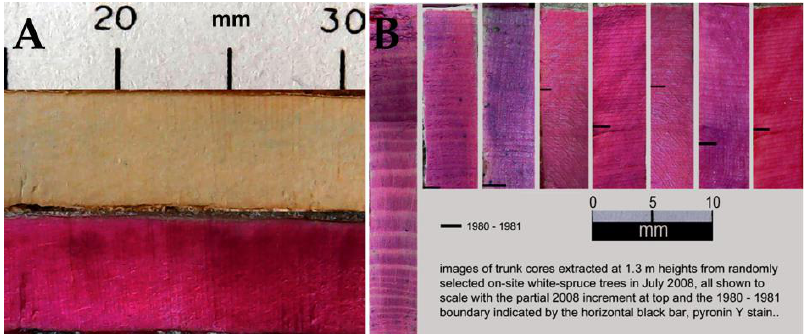
Figure 12. ( A ) Part of a white-spruce core before and after staining with pyronin Y. Examples of variation in cores obtained at 1.3 m trunk height from randomly sampled white-spruce trees. ( B ) Breast-height cores extracted in 2008 from trunks of 8 trees, showing the latewood – earlywood boundary as a black horizontal dash between the 1980 and 1981 growth layers.